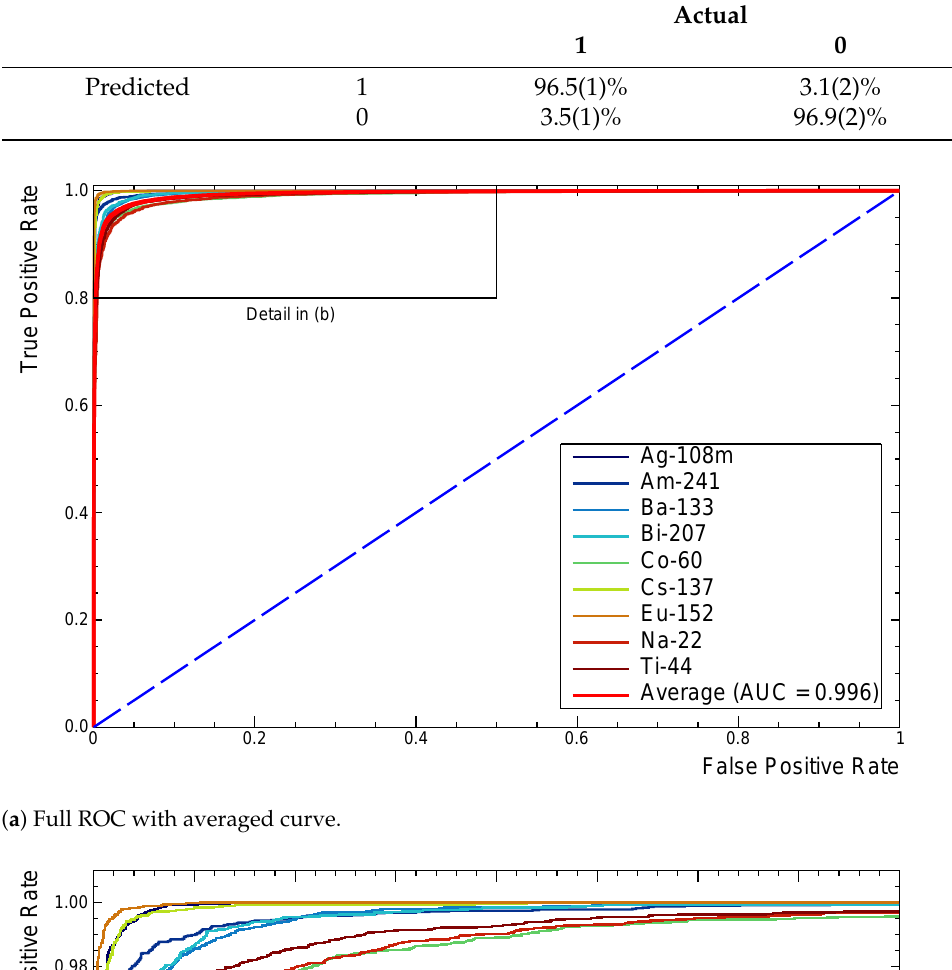
Table 3. Overall classification rates for the reference model.